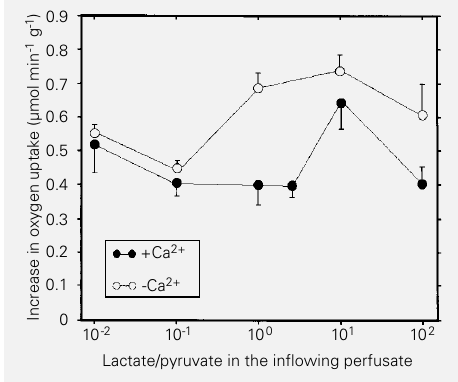
Figure 3 - Changes in oxygen consumption in the rat liver upon the infusion of lactate plus pyru- vate at different ratios in the presence (filled circles) and ab- sence (open circles) of Ca 2+ . The data are from the same experi- ments as described in the leg- end to Figure 1. Oxygen uptake was followed polarographically. The changes are the differences between the new steady state in the presence of lactate plus pyruvate and the steady state during substrate-free perfusion. Each data point represents the mean of 3 to 5 liver perfusion experiments. The vertical bars represent the standard errors of the